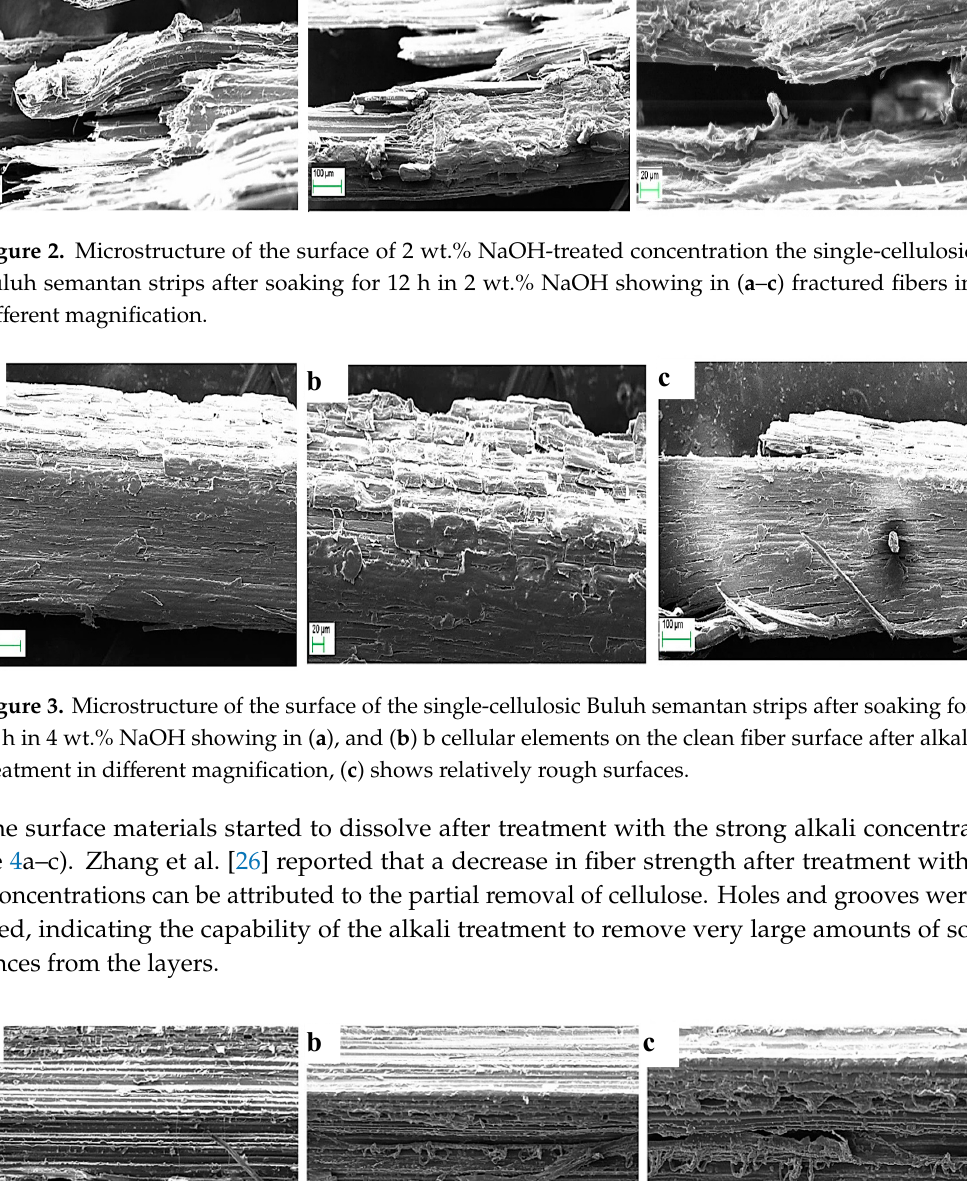
Figure 4. Microstructure of the surface of the single-cellulosic Buluh semantan strips after soaking for 12 h in 8 wt.% NaOH showing in ( a ) fractured fibers, ( b ), and ( c ) holes and grooves on fiber